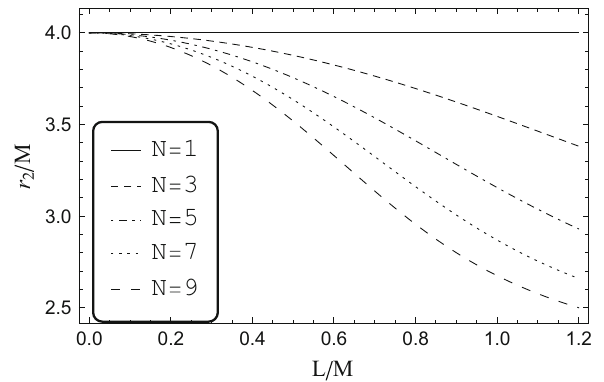
Fig. 7 Dependence of inner boundary of the SEC ( r 2 ) in the non- singular non-rotating spacetime in conformal gravity on the parameters L and